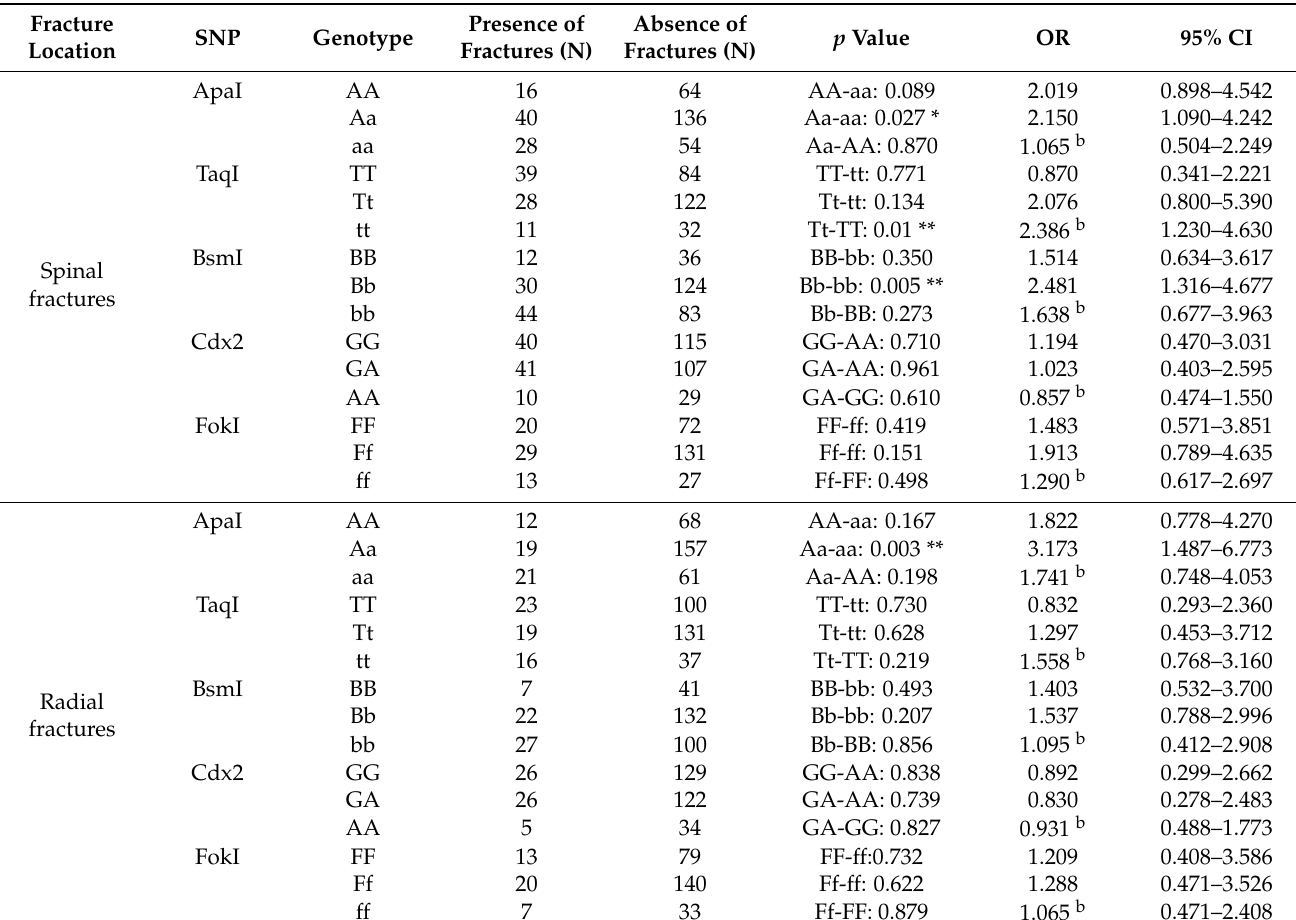
Table 5. The effects of the VDR genotypes on fracture